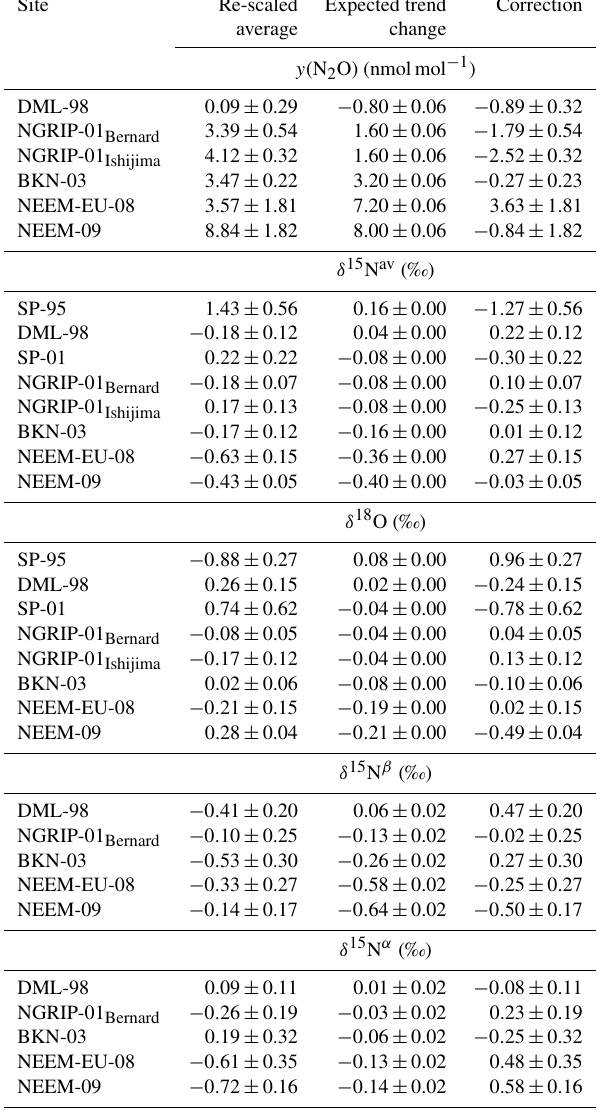
Table B1. Implemented scaling for the N 2 O mole fraction and isotopic composition. The re-scaled average was extracted from the diffusivity zone for each site, which corresponds to the top 50m. The expected trends are averaged values from CSIRO (http: //www.csiro.au/greenhouse-gases) for the last 30 years for the mole fraction and measured trends from Röckmann and Levin (2005) for the isotopic composition. The rather large corrections to the iso- tope data from the SP-01 and SP-95 drillings are likely due to inter- laboratory-scale